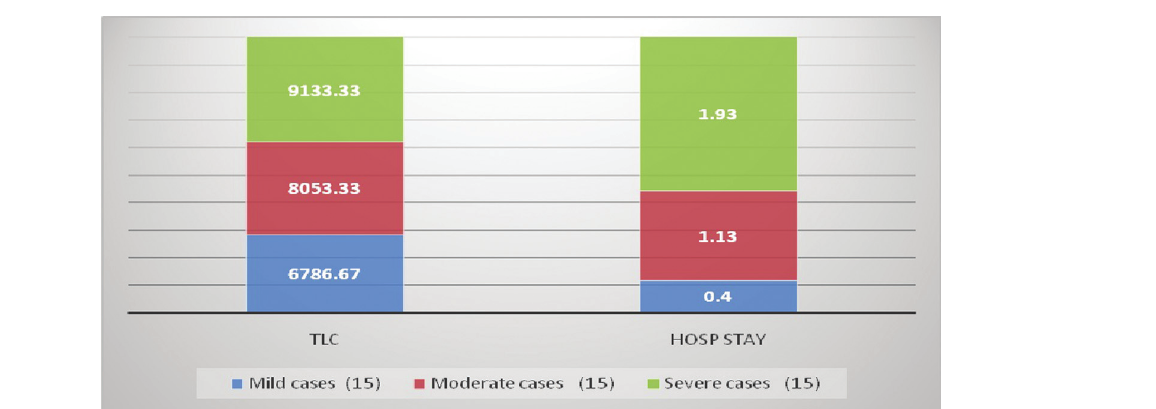
Comparison between the studied groups according to total leukocytic count and hospital stay.